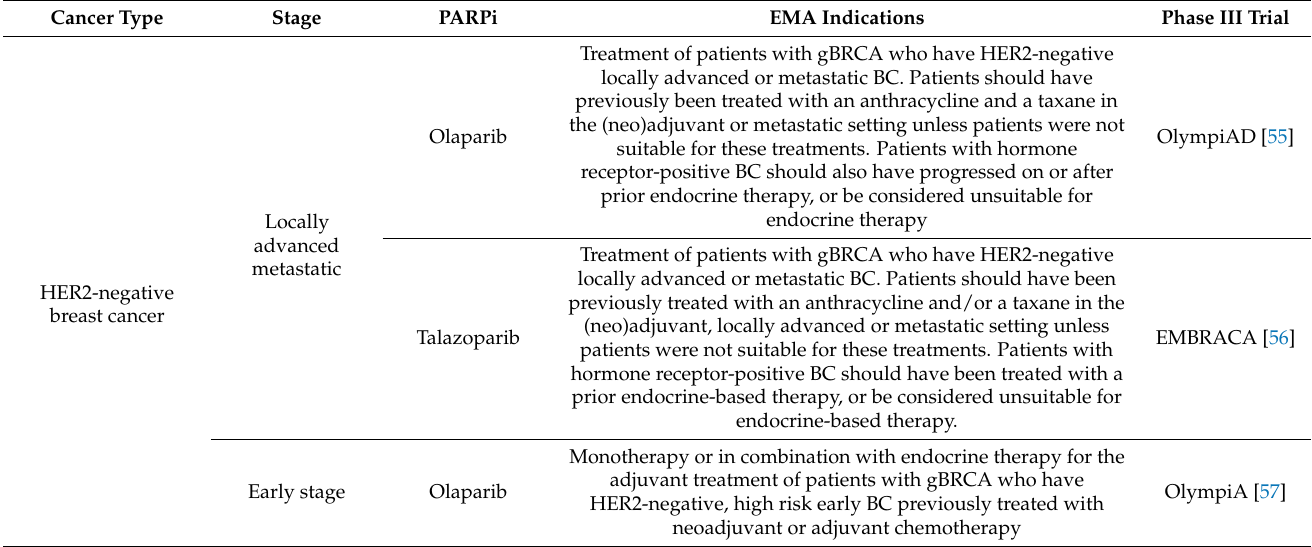
Table 2. EMA-approved PARPi for BC, OC, pancreatic and prostate cancer, and the related phase III baseline trial (g BRCA : germline P/LPV in BRCA ; g/sBRCA : germline or somatic P/LPV in BRCA